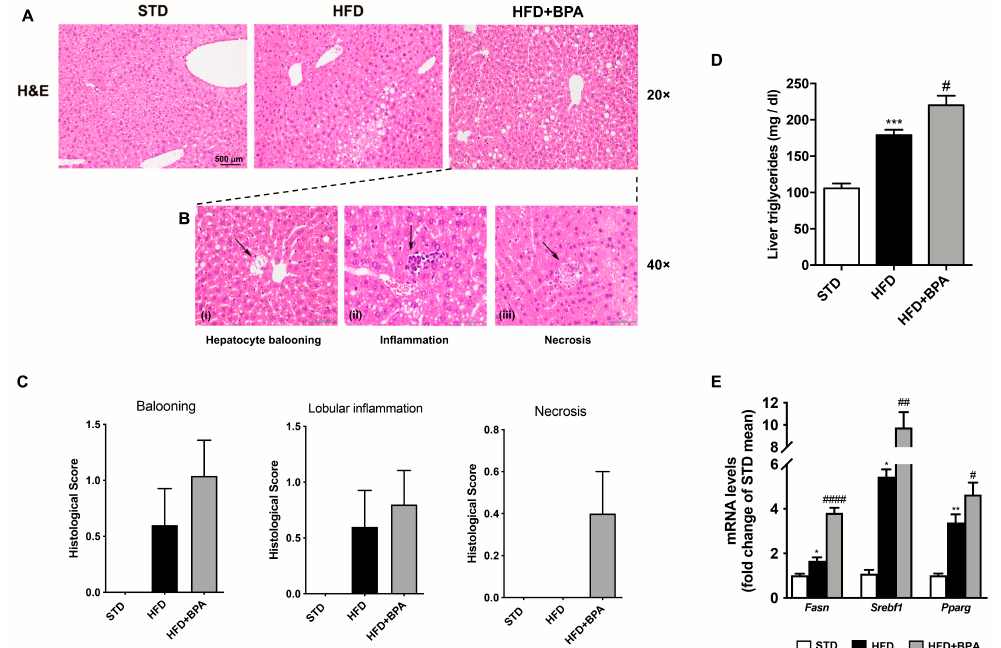
Figure 2. BPA exposure worsens hepatic steatosis and inflammation in HFD-fed mice. ( A ) H&E staining was performed on the liver from all groups of animals (magnification 20 × ) ( n = 4 each group). ( B ) (i) The appearance of the ballooning degeneration, (ii) the inflammatory and (iii) necrotic lesions in the liver from HFD + BPA, and ( C ) the histological score for all three groups were shown. ( D ) Hepatic triglycerides and mRNA expression of ( E ) Fasn , Srebf1 , and Pparg were determined. Data are presented as means ± SEM of all animals (n = 6 each group) (* p < 0.05 vs. STD, ** p < 0.01, *** p < 0.001, # p < 0.05, ## p < 0.01, and #### p < 0.0001 vs. HFD).